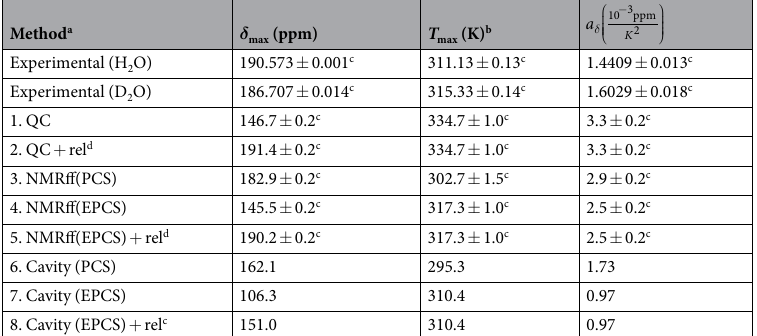
Table 1. Experimental and computational values of the maximum value δ max of the 129 Xe chemical shift in aqueous solution of atomic Xe, the temperature T max at which it occurs and the “curvature” a δ of the chemical shift, obtained with different methods. The parameters δ max , T max and a δ were determined by fitting the shift vs. 2 δ δ = − − a Different computational methods temperature data to a quadratic polynomial T a T T ( ) ( ) δ . max max